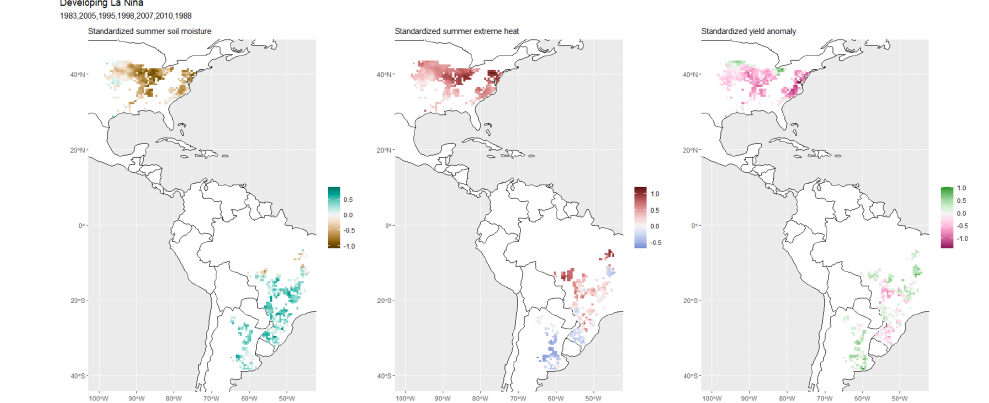
Earth Syst. Dynam., 14, 255–272,